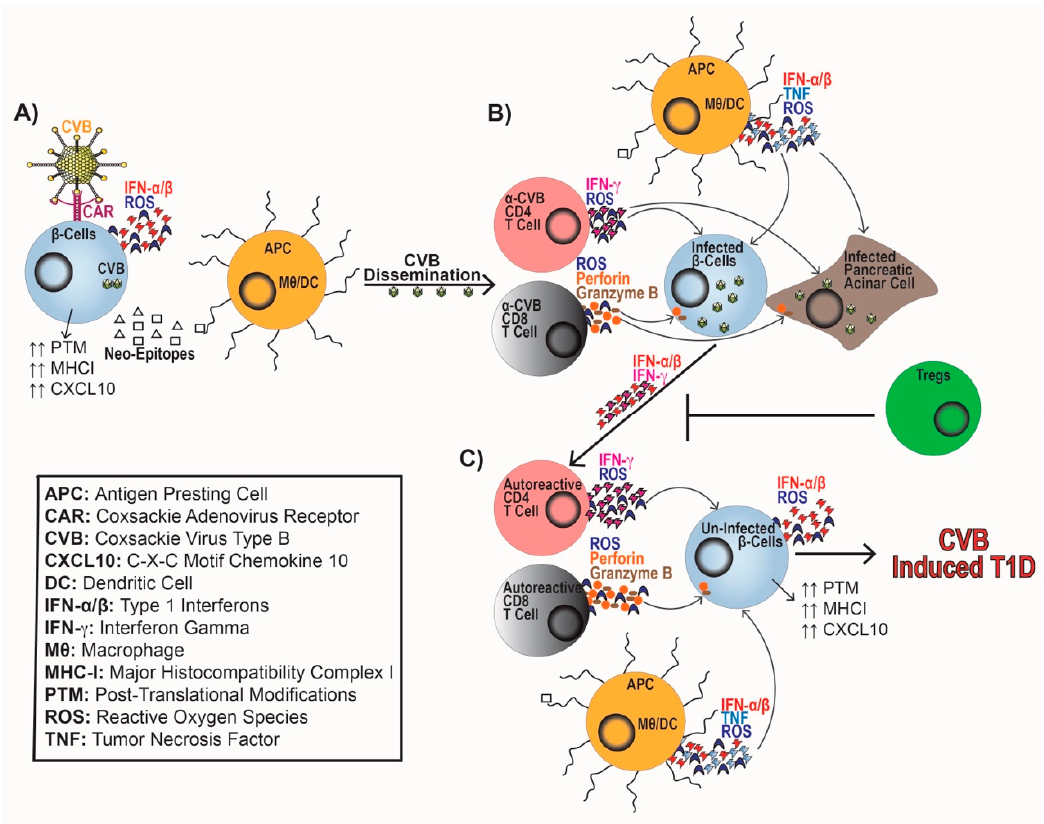
Figure 1. Model of coxsackievirus type B (CVB)-induced type 1 diabetes (T1D). ( A ) Coxsackievirus binds to the Coxsackievirus and Adenovirus Receptor (CAR) on the β -cell leading to β -cell infection, cellular dysregulation, interferon-alpha and -beta (IFN- α / β ) synthesis, and generation of neo-epitopes. Phagocytosis and presentation of neo-epitopes by antigen-presenting cells (APCs) leads to the activation of autoreactive CD4 and CD8 T cells. ( B ) CVB dissemination leads to the generation and di ff erentiation of CVB-specific CD4 and CD8 T cells. Both CD4 and CD8 T cells will gain e ff ector responses, CD4 T cells will produce ROS and IFN- γ . Whereas, CD8 T cells will produce ROS, perforin, and granzyme B targeting infected β -cells and acinar cells, while APCs will concomitantly produce ROS, IFN- α / β , and TNF to promote viral clearance and immune cell activation. ( C ) The proinflammatory response to CVB infection and generation of IFN- α / β and IFN- γ leads to the loss of Treg peripheral tolerance. Subsequent activation of proinflammatory APCs and autoreactive CD4 and CD8 T cells further propagate CVB-induced T1D.